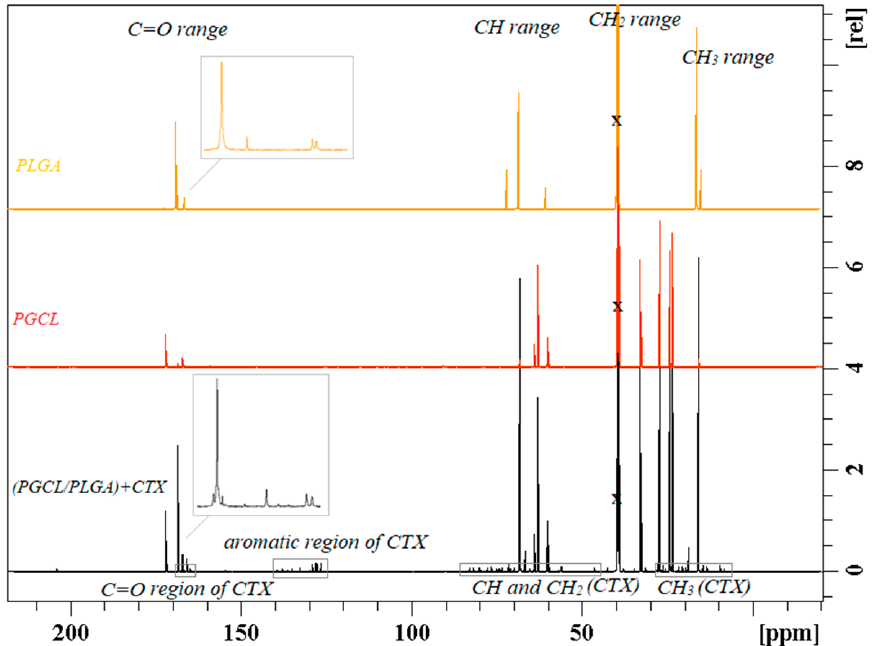
Figure 8. 13 C NMR spectrum of (PGCL/PLGA) + CTX patches in DMSO-d6 with the description of the spectral range of main functional groups in the polymer chain (descriptions above the spectra) and assignment of the peaks associated with cabazitaxel (descriptions in the bottom of the spectra).